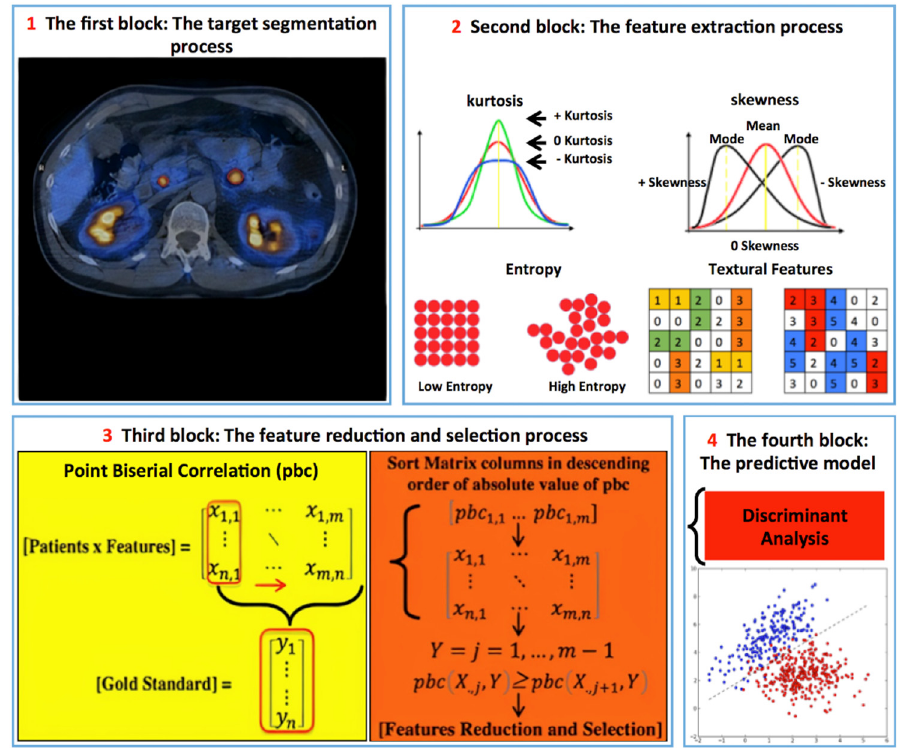
Figure 2. Radiomics’ workflow. ( 1 ) 324 GEP NET lesions with high SSTRs expression